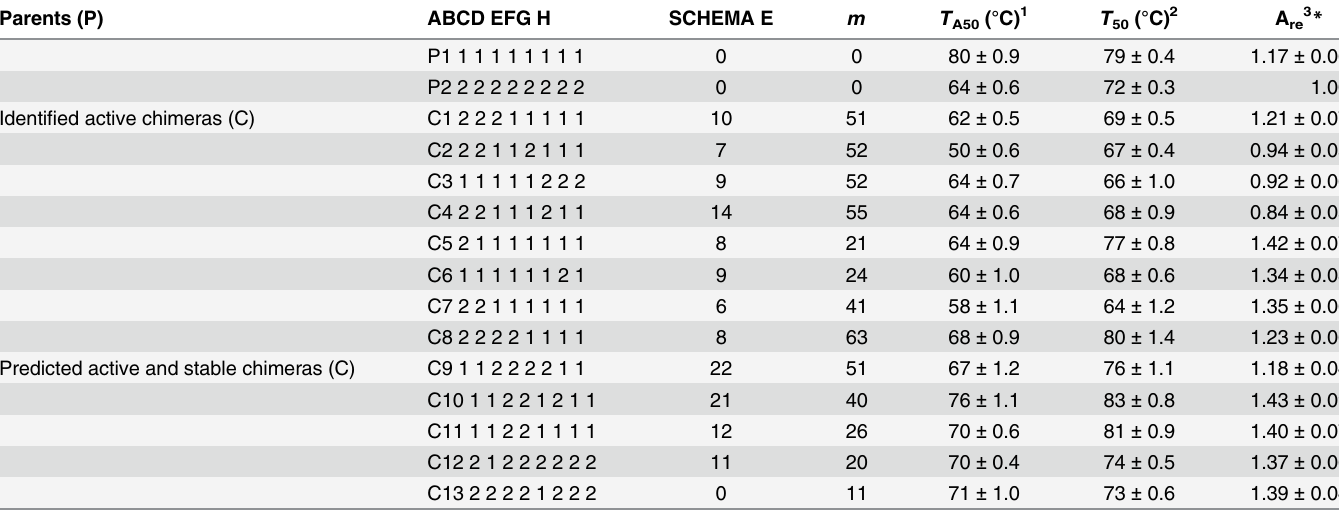
Table 1. Informative subsets of parental, chimeric, and designed GH5